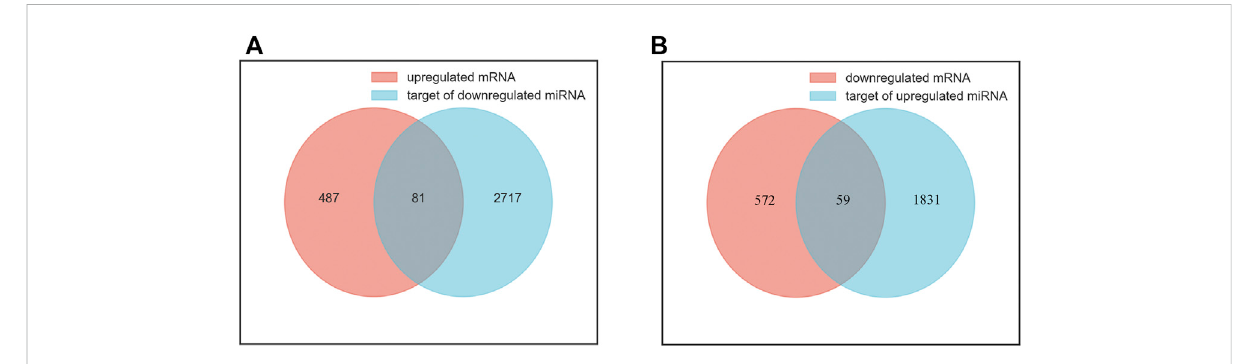
FIGURE 2 Identi fi cation of overlapping genes. (A) the intersection of upregulated mRNAs (red) and target genes of downregulated miRNAs (blue). (B) the intersection of downregulated mRNAs (red) and target genes of upregulated miRNAs